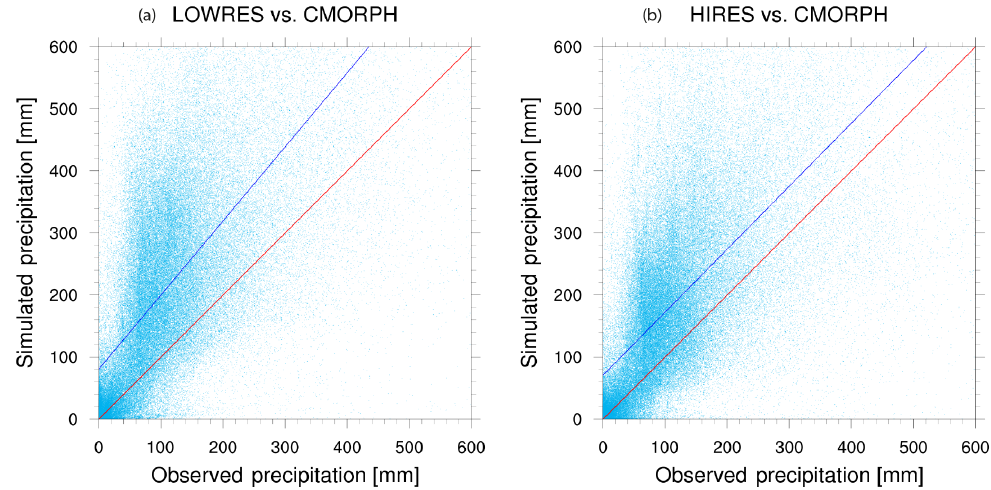
Figure 17. Scatter plot of the accumulated precipitation over the 2-month period including regression lines. The left panel shows the LOWRES simulation versus the CMORPH data. The red line indicates the perfect result. The right panel shows the HIRES simulation versus the CMORPH